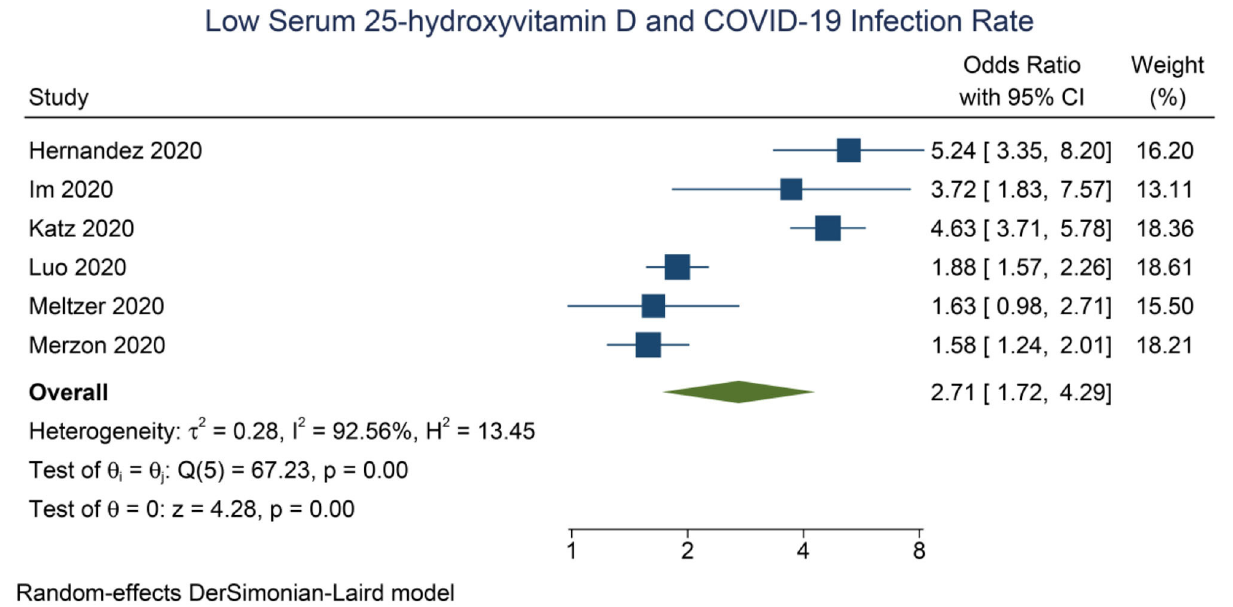
serum 25-OHD, however, a data of 1,326 patients from the UK biobank cohort indicates that Vitamin D level, adjusted with gender, age, and ethnicity was not significant for susceptibility to